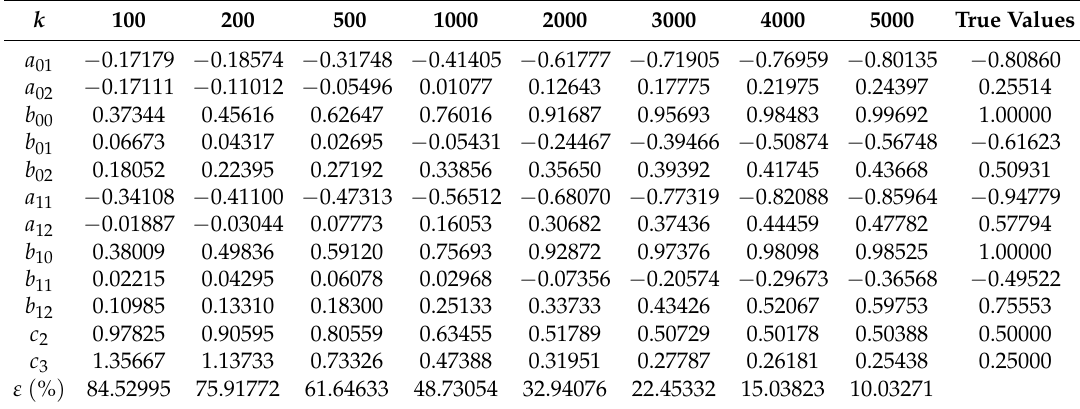
Table 2. The AM-MISG parameter estimates and errors ( p = 5).